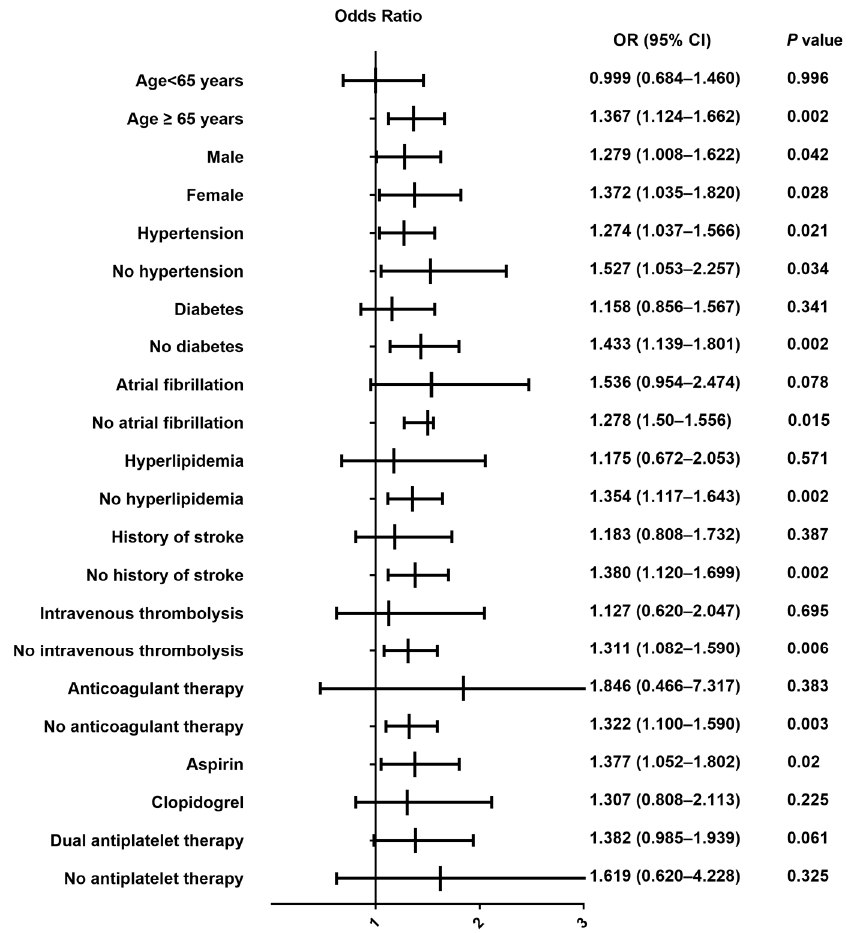
Figure 2. Forest plots for a poor outcome at one year in patients with different baseline characteris-